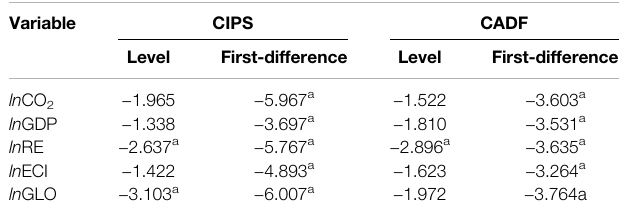
TABLE 4 | Unit root test results.